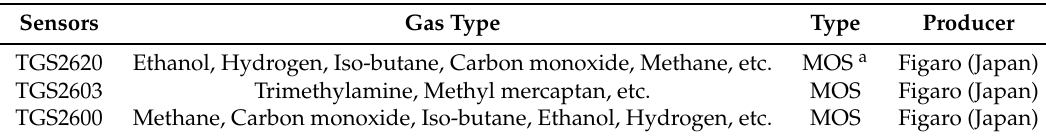
Table 2. Gas sensors sensitivity characteristics a .